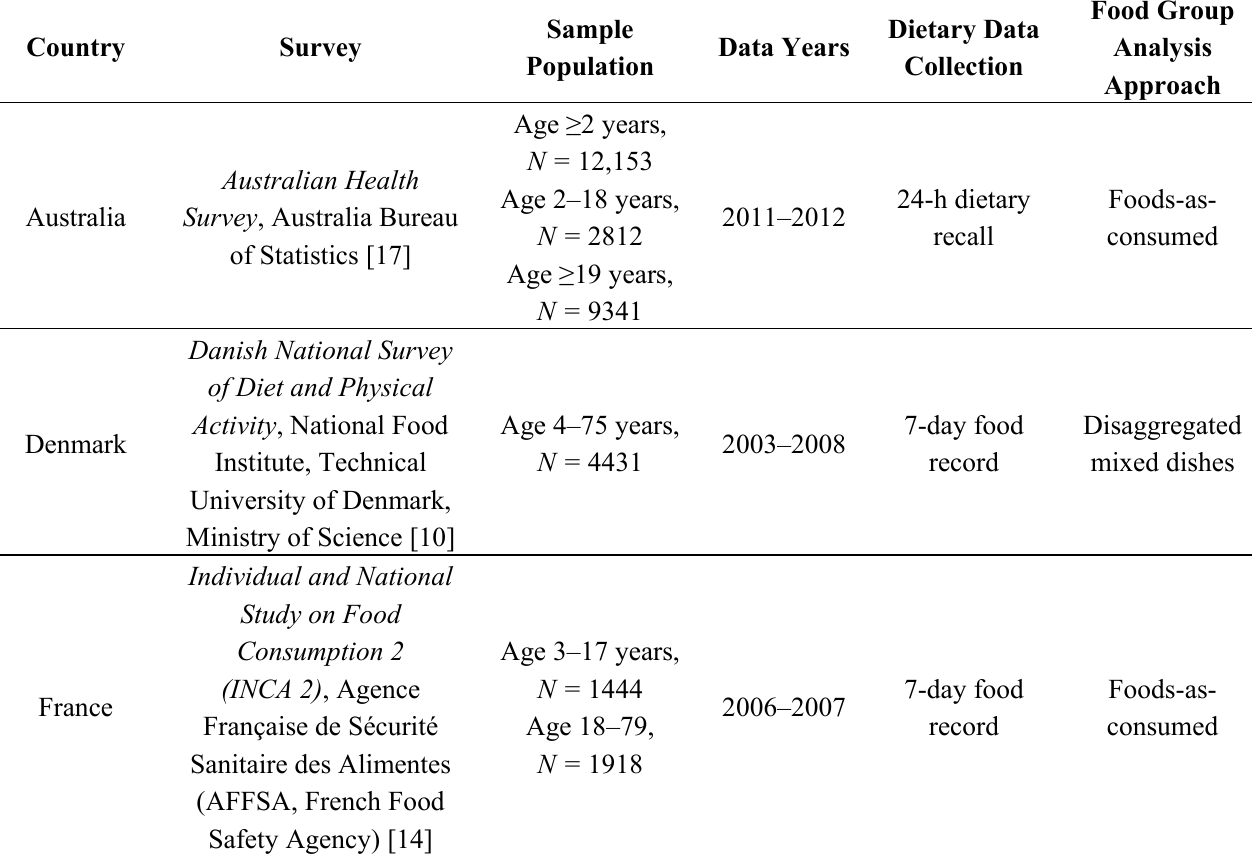
Table 1. Food consumption surveys in five developed